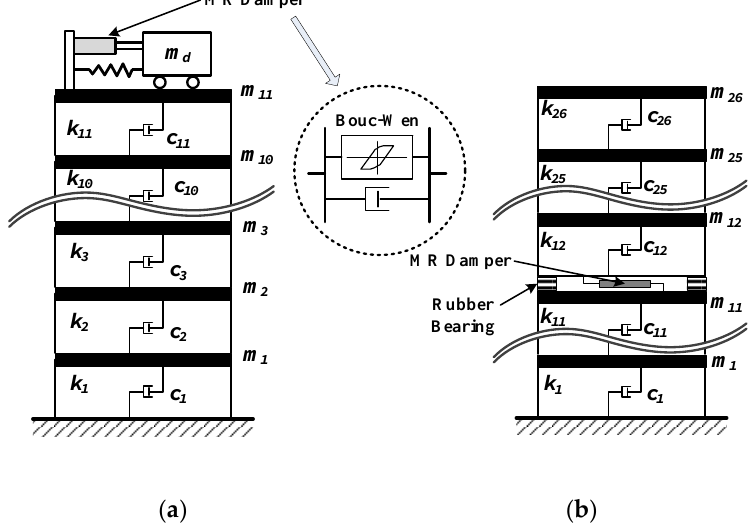
( b ) Figure 3. Outline of the seismic response simulation model of a seismic-excited structure with semi- active control system: ( a ) Conventional model; ( b ) RNN-based model.